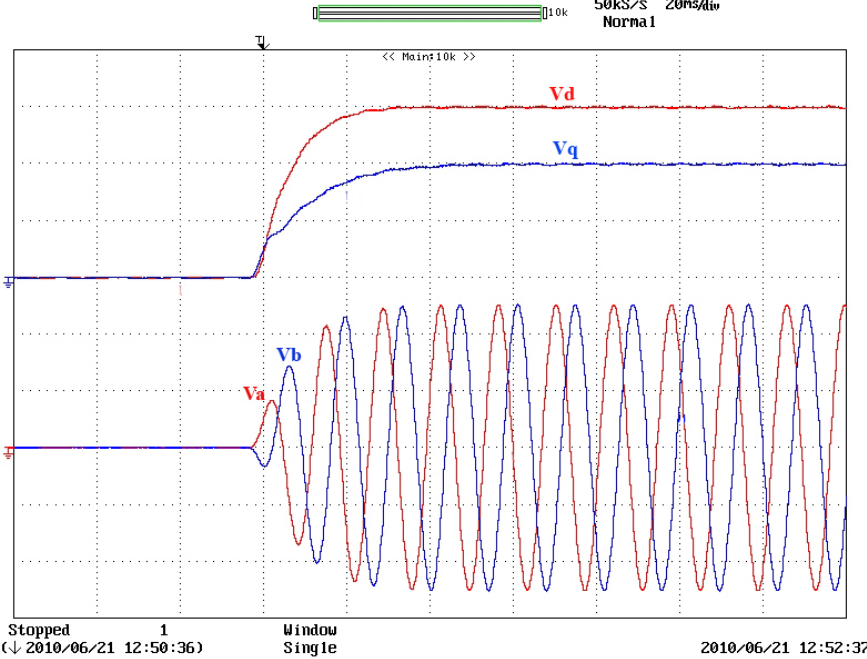
Figure 8. Oscilloscope screen capture of the d and q components of the load voltage, and the phase a and b voltages of the